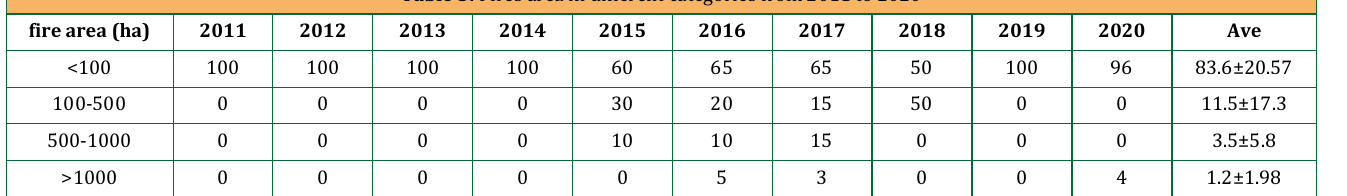
Table 3: Fires area in different categories from 2011 to 2020